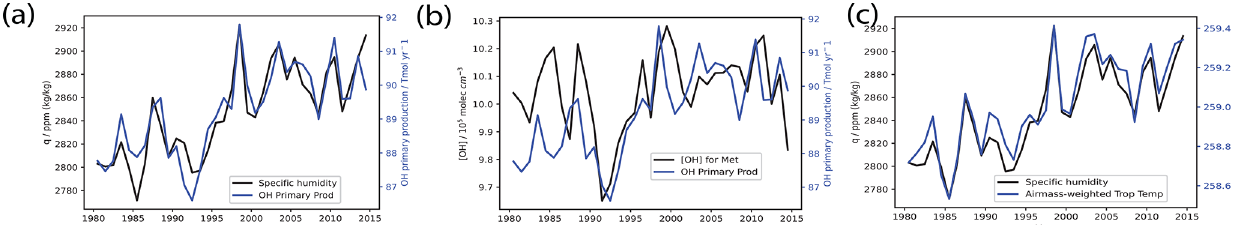
Figure 9. OH primary production and [OH] in the meteorology-driven (Met) run. Panel (a) shows the comparison between specific humidity (left-hand y axis, black) and OH primary production (right-hand y axis, blue) in the meteorology-driven run, panel (b) shows the [OH] (left-hand y axis, black) compared with OH primary production (right-hand y axis, blue), and panel (c) shows the comparison between specific humidity (left-hand y axis, black) and tropospheric air-mass-weighted air temperature (right-hand y axis, blue). Meteorology plays an important role for IAV in OH primary production, with OH primary production being strongly correlated with changes in specific humidity ( q ) ( r = 0 . 90), which itself is strongly correlated with temperature ( r = 0 . 96).